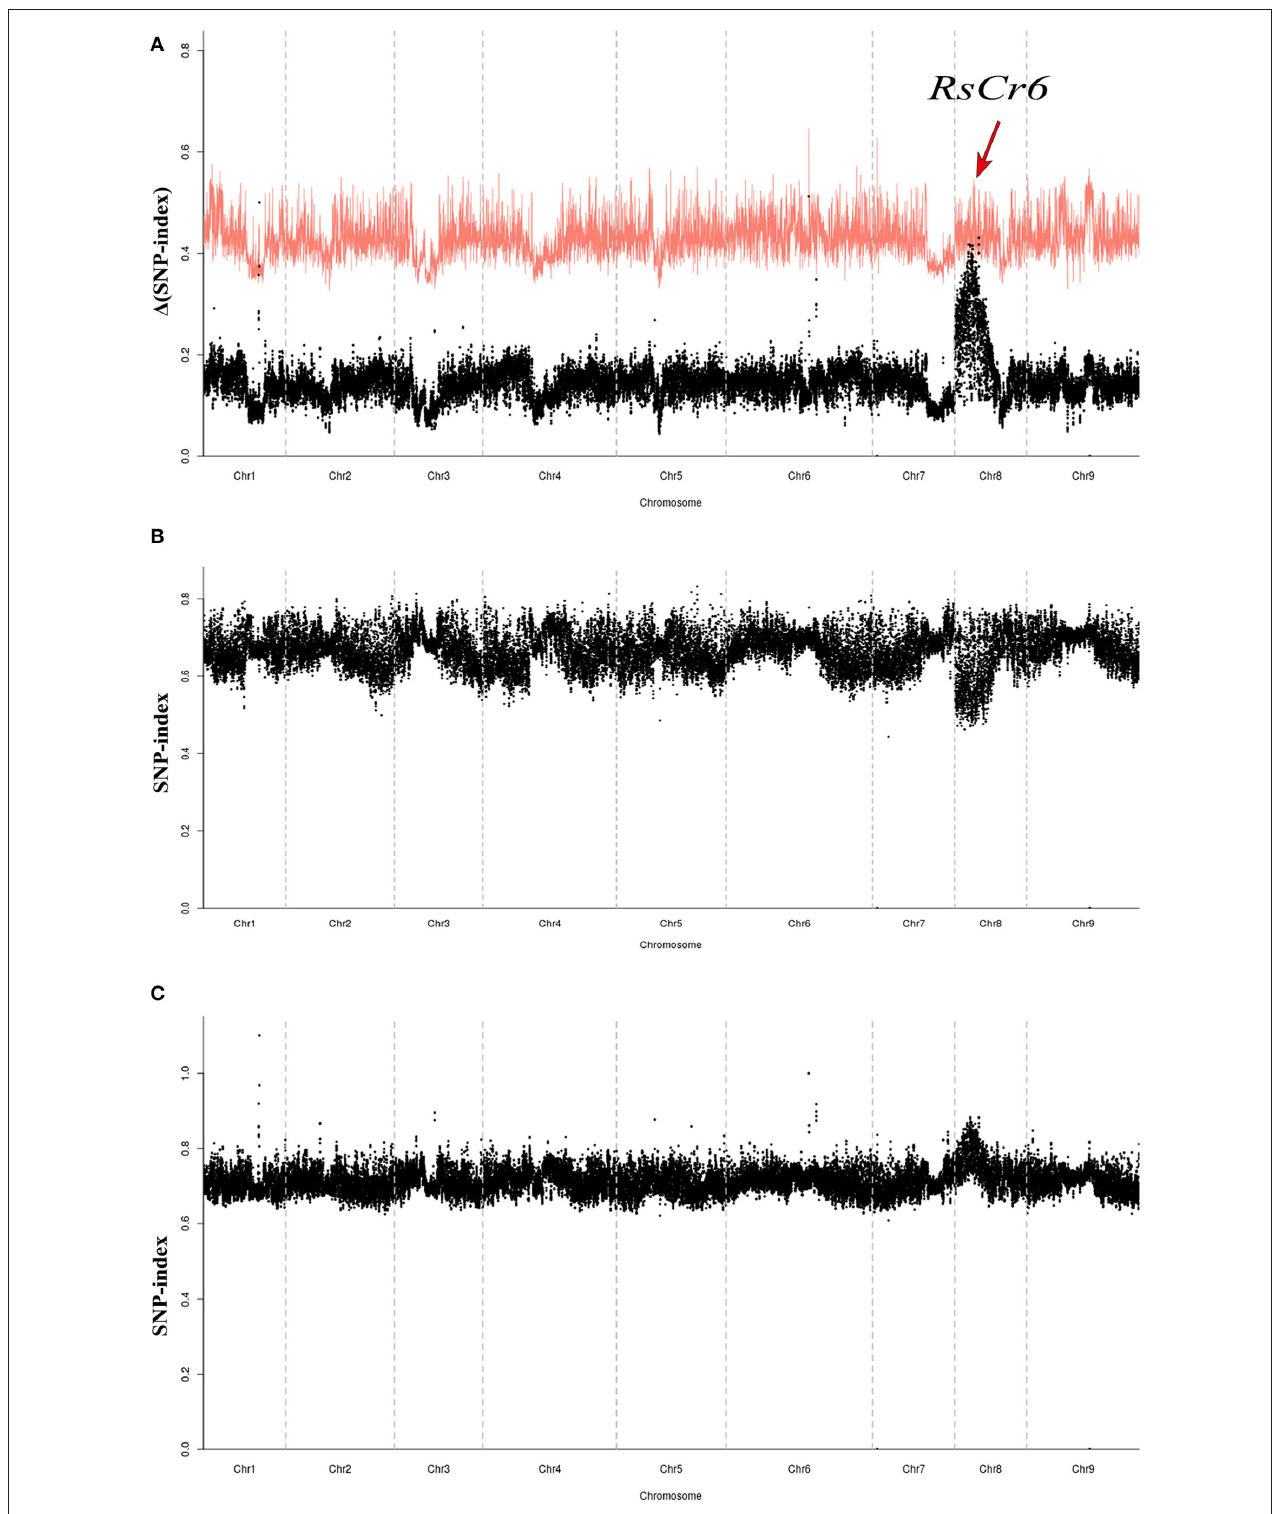
FIGURE 2 | Identification of novel quantitative trait locus (QTL) related to clubroot resistance in radish. (A) Plot of 1 (SNP-index) value based on S-pool and R-pool data against the reference genome “QZ-16.” The target peak (red arrow) of the novel clubroot resistance locus RsCr6 was identified on chromosome Rs8. The confidence interval ( CI ) is indicated in red ( p < 0.05). (B) Distribution of single nucleotide polymorphism (SNP)-index value based on S-pool data. (C) Distribution of SNP-index value based on R-pool data.